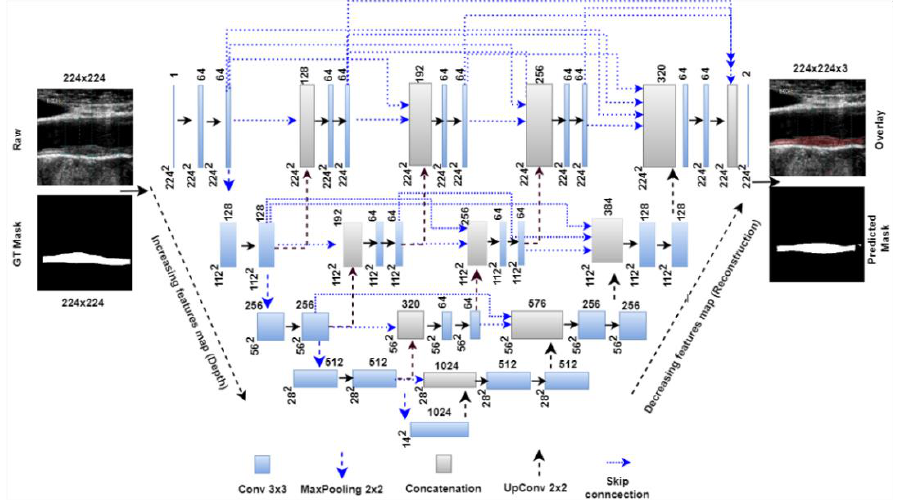
Figure A2. UNet++ Architecture. Figure A1. UNet++ Architecture.